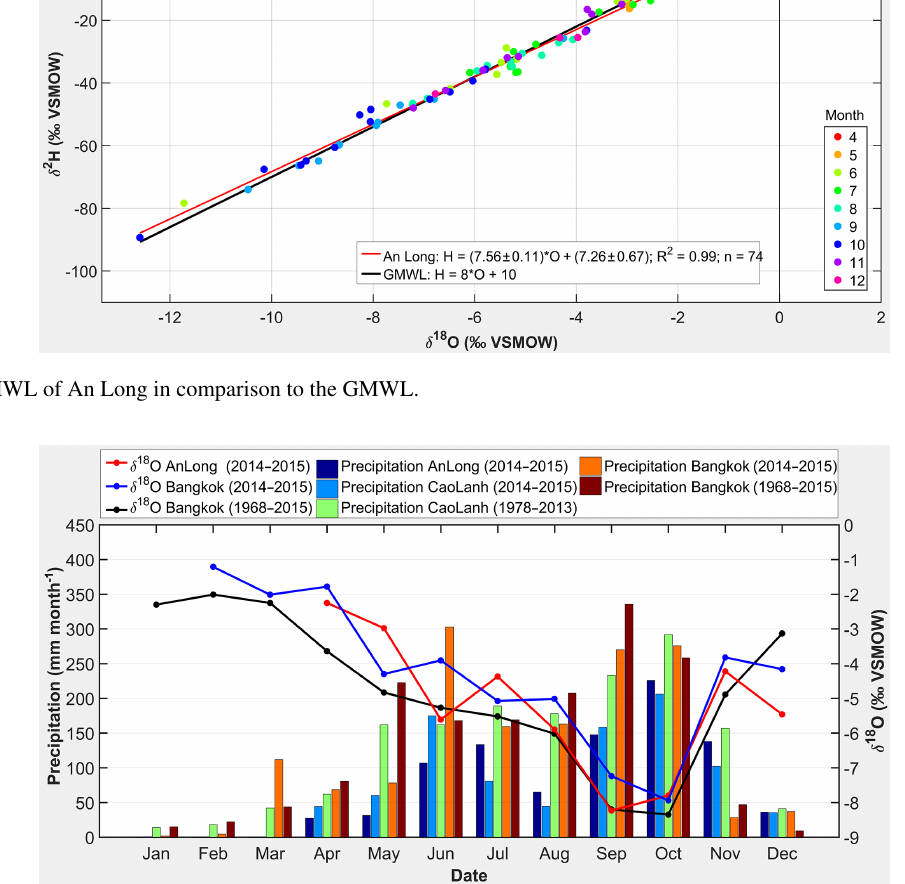
Figure 8. Seasonal variation in the average monthly precipitation for An Long and Cao Lanh and δ 18 O values of precipitation for An Long (for the period of observation – red) and Bangkok (both for the period of observation – blue – and the long-term mean –